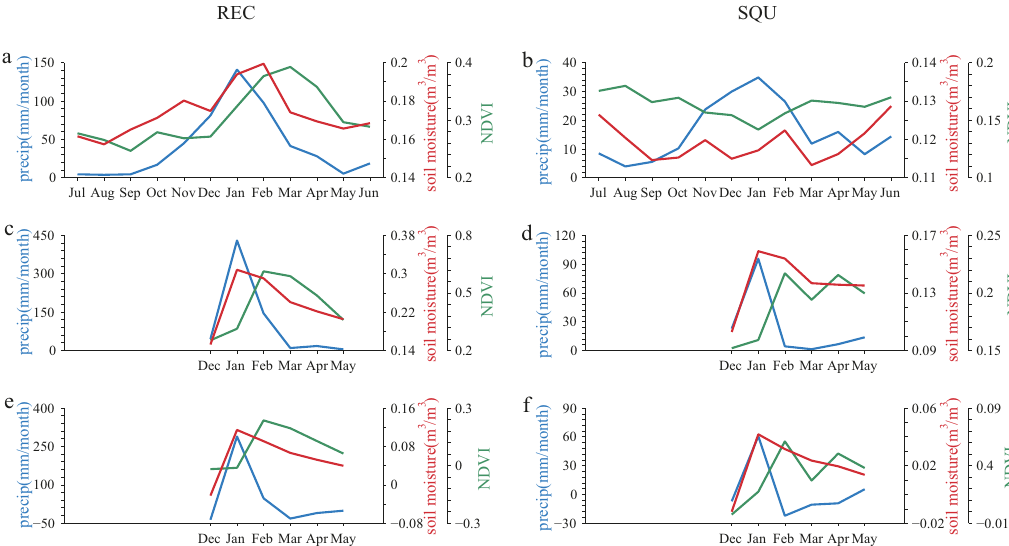
Figure 4. Seasonal patterns of precipitation (mm/month, blue), soil moisture (m 3 /m 3 , red), and NDVI (unitless, green) over sub-regions REC (left column of panels) and SQU (right column of panels). The locations of these two sub-regions are shown on Figure 1. Long-term 1998–2009 monthly averages are illustrated in subplots ( a , b ). The case period (December 2008–May 2009) monthly series of original data are shown in subplots ( c , d ), and anomalies are shown in subplots ( e , f ), respectively. Note the different units of the Y-axes between the REC and SQU cases.